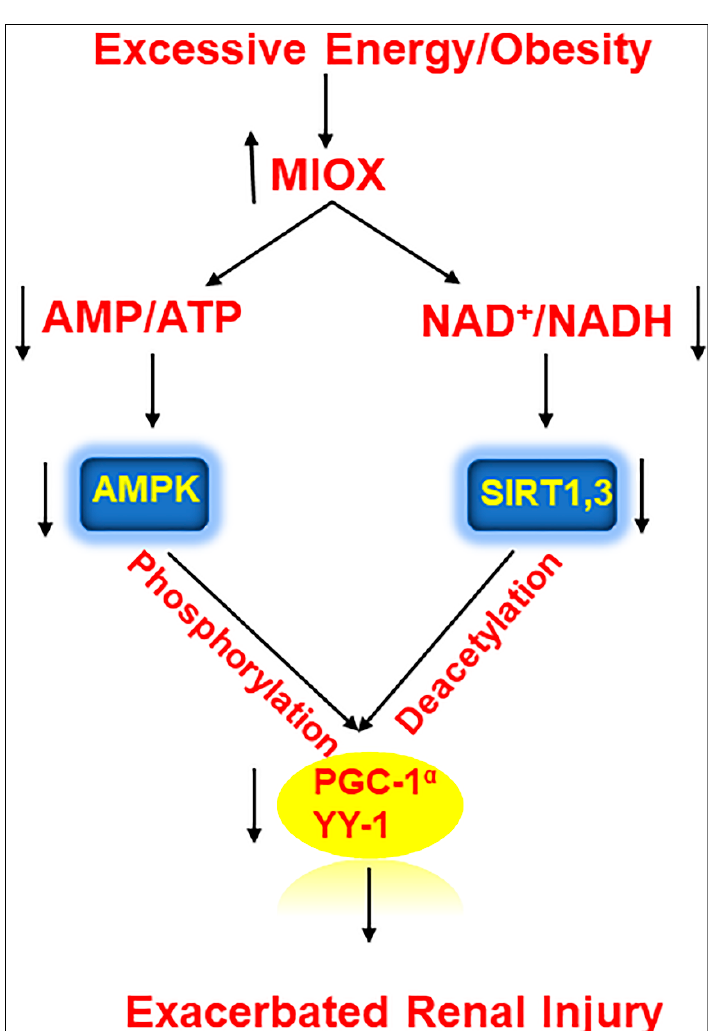
Figure 4. Schematic representation of series of events involved in the exacerbation of renal injury with MIOX overexpression in the setting of obesity. Hyperlipidemic ambience increases the expression of MIOX. Subsequently there are perturbations in cellular redox potential. Conceivably, this is followed by downregulation of various metabolic sensors and related modulators including p-AMPK α , Sirt1 / Sirt3, PGC1- α and YY-1, ultimately leading to an accentuation of renal